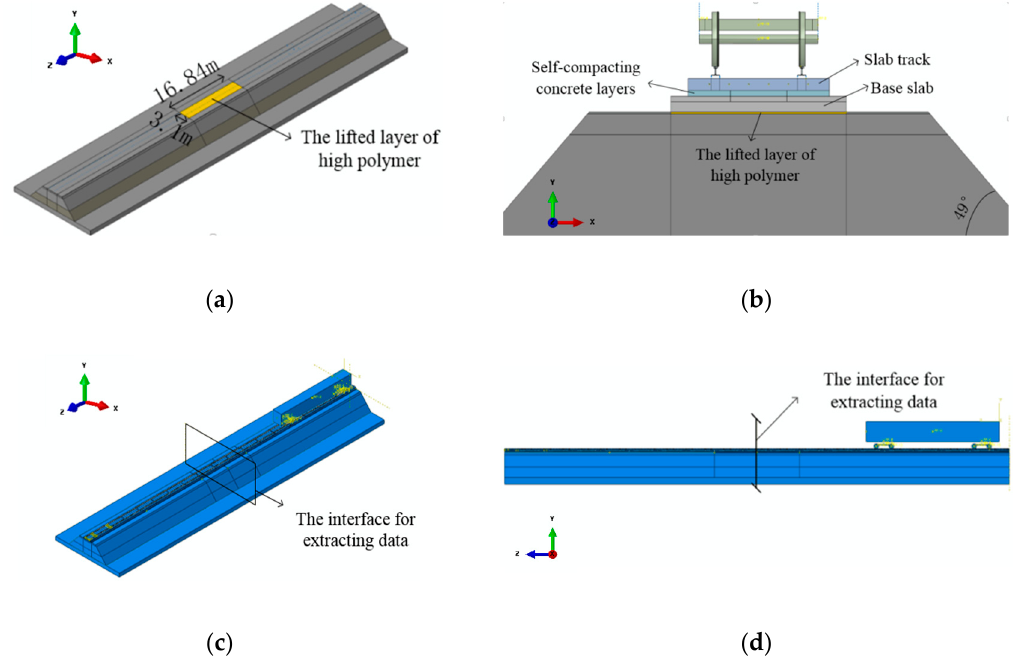
Figure 9. Location of the void. ( a ) Overall perspective, ( b ) cross-sectional perspective, ( c ) oblique drawing of the section, ( d ) horizontal drawing of the section.